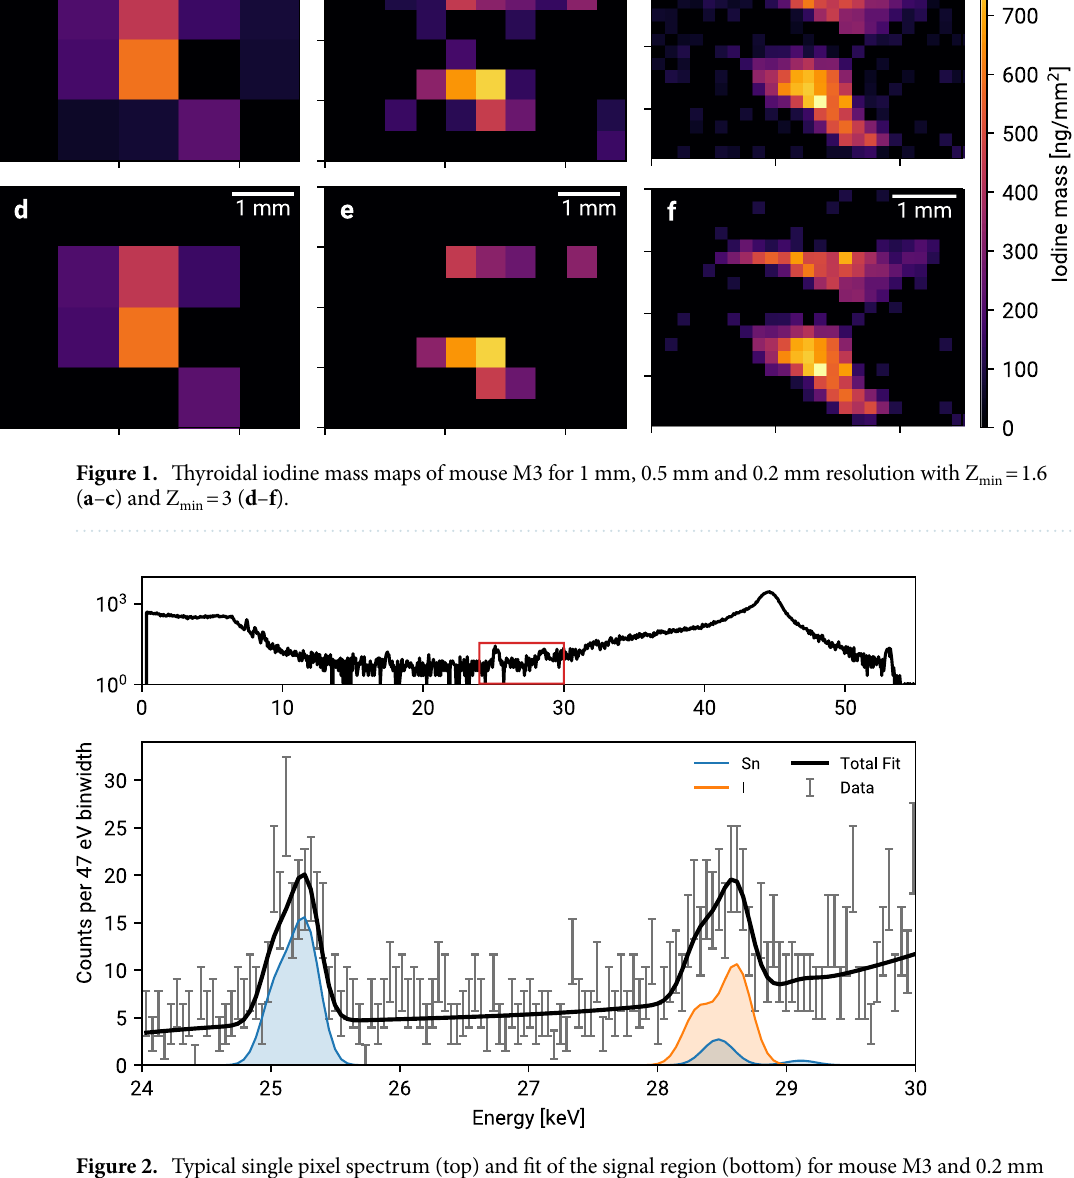
Figure 2. Typical single pixel spectrum (top) and fit of the signal region (bottom) for mouse M3 and 0.2 mm resolution. Detector intrinsic tin fluorescence is present and has to be taken into account for correct iodine